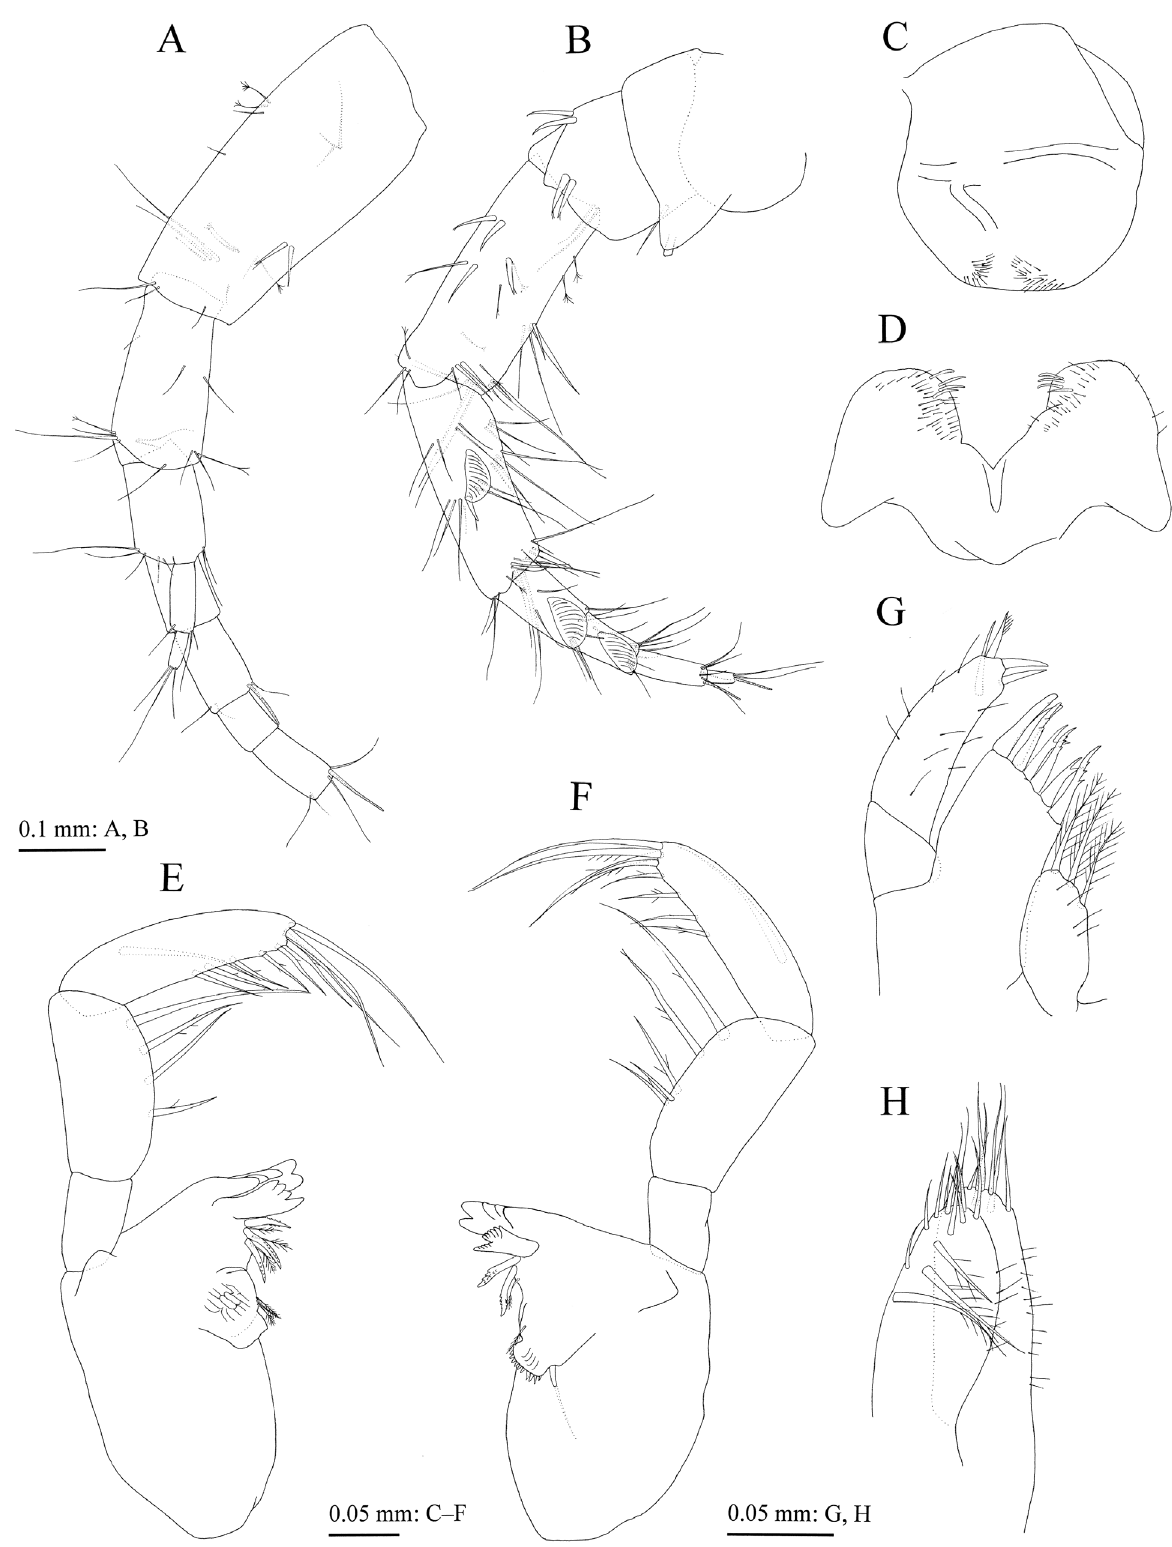
Figure 3. Pseudocrangonyx gudariensis Tomikawa & Sato, sp. n., holotype, male (3.9 mm), NSMT-Cr 24603. A antenna 1, medial view; B antenna 2, medial view; C upper lip, anterior view; D lower lip, ventral view; E left mandible, medial view; F right mandible, medial view; G maxilla 1, dorsal view; H maxilla 2, dorsal